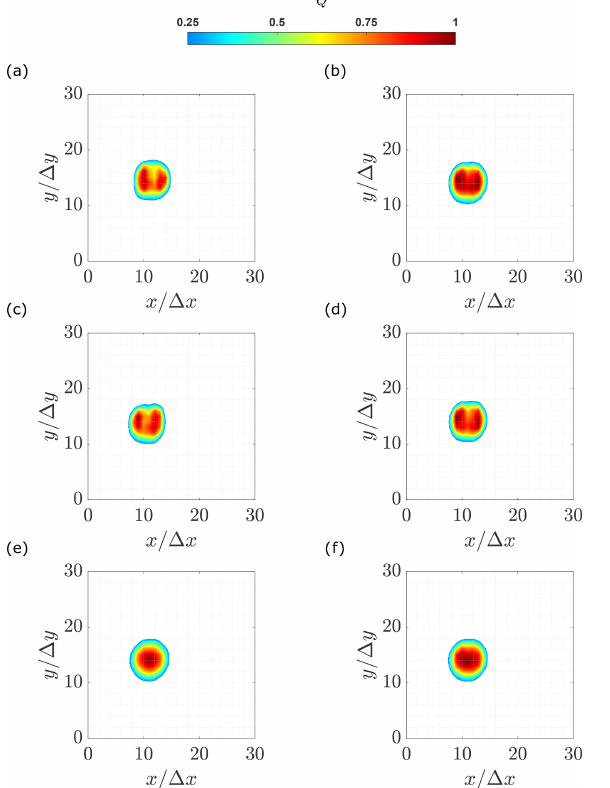
Figure 7. Normalized vorticity magnitude on the area of interest. (a) Backward difference. (b) Central difference. (c) Forward differ- ence. (d) Richardson extrapolation. (e) Least square. (f) Circulation method.